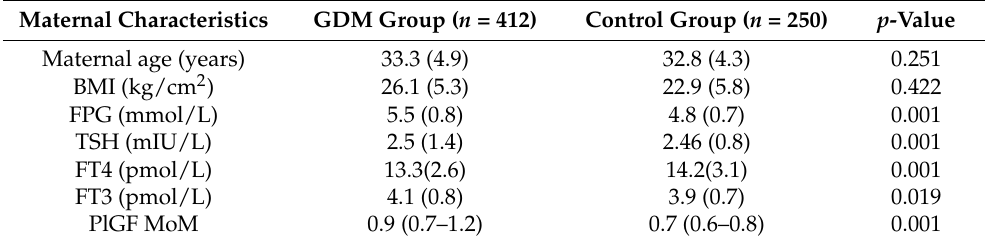
Table 1. Maternal characteristics and biochemical parameters of observed women. Maternal